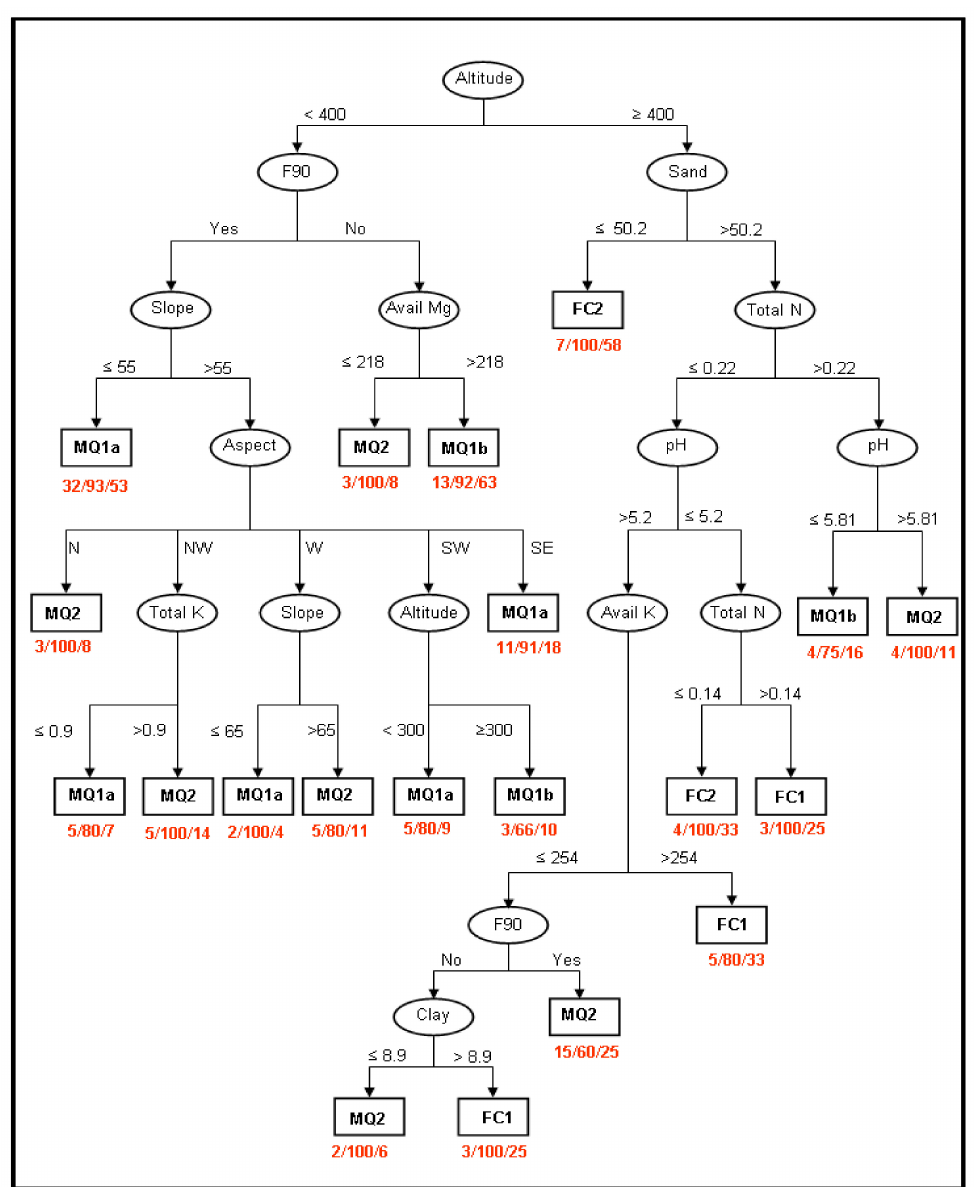
Figure 6. Classification tree showing the distribution of the three communities and two sub-communities in relation to environmental factors and fire regime. The terminal nodes are shown in rectangular blocks. Inside each of the non-terminal nodes (ellipsoid) the variable used to make the split is shown and the threshold values are shown along the branches. Inside each of the terminal nodes the predicted community or sub-community is shown. The three numbers under each of the terminal nodes indicate: number of instances/correct classification rate (%)/Percentage of the respective community found under the particular branch. Avail = Available, F90 = Fire in 1990, all total nutrients are in percentage (%) and all available nutrients in mg/kg. Clay and Sand are in percentage